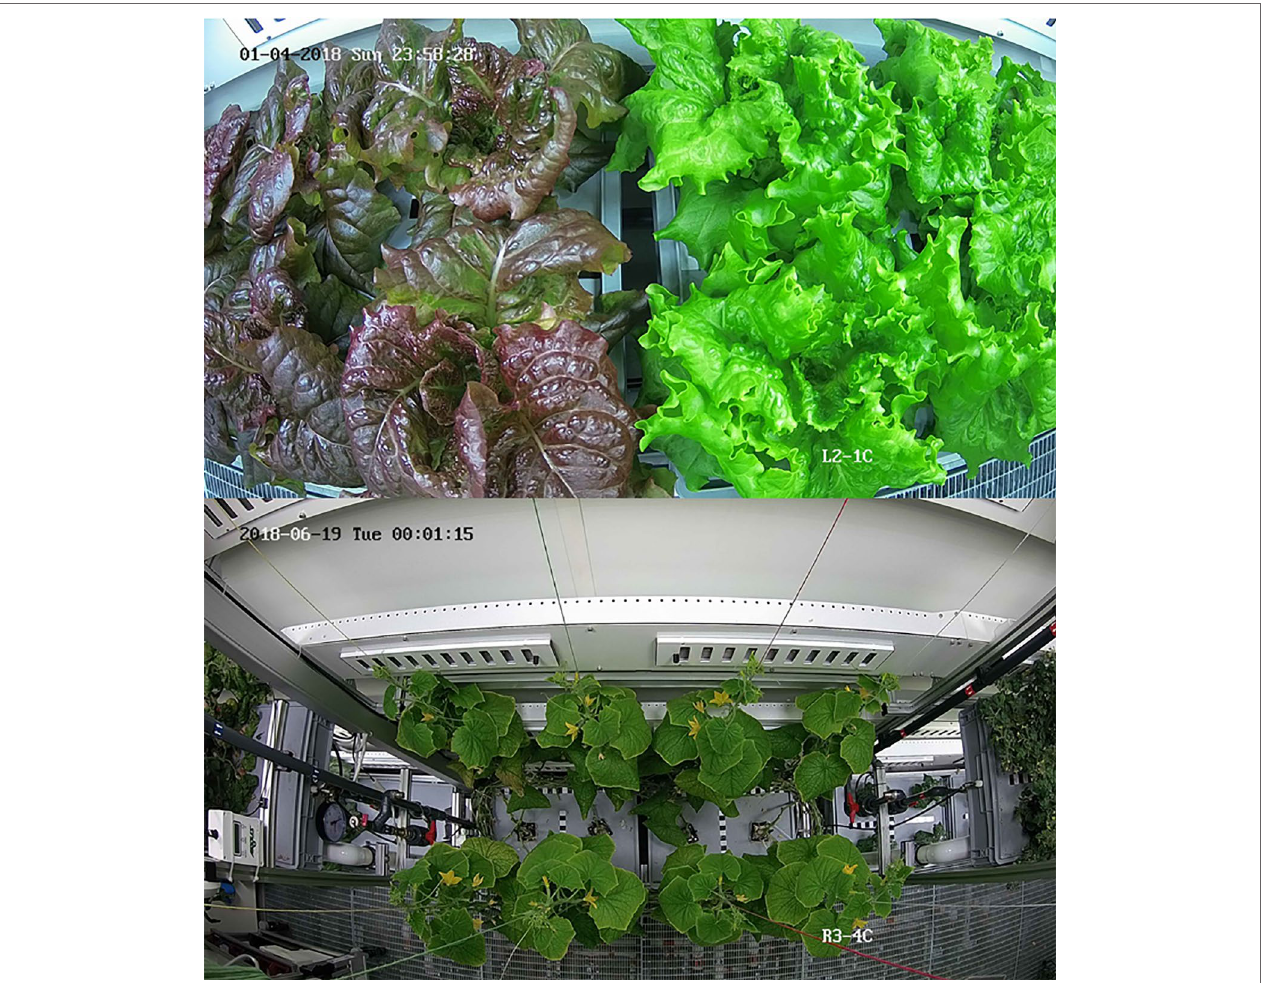
FIGUrE 6 | Top view images of lettuce plants (top) and cucumber plants (bottom).